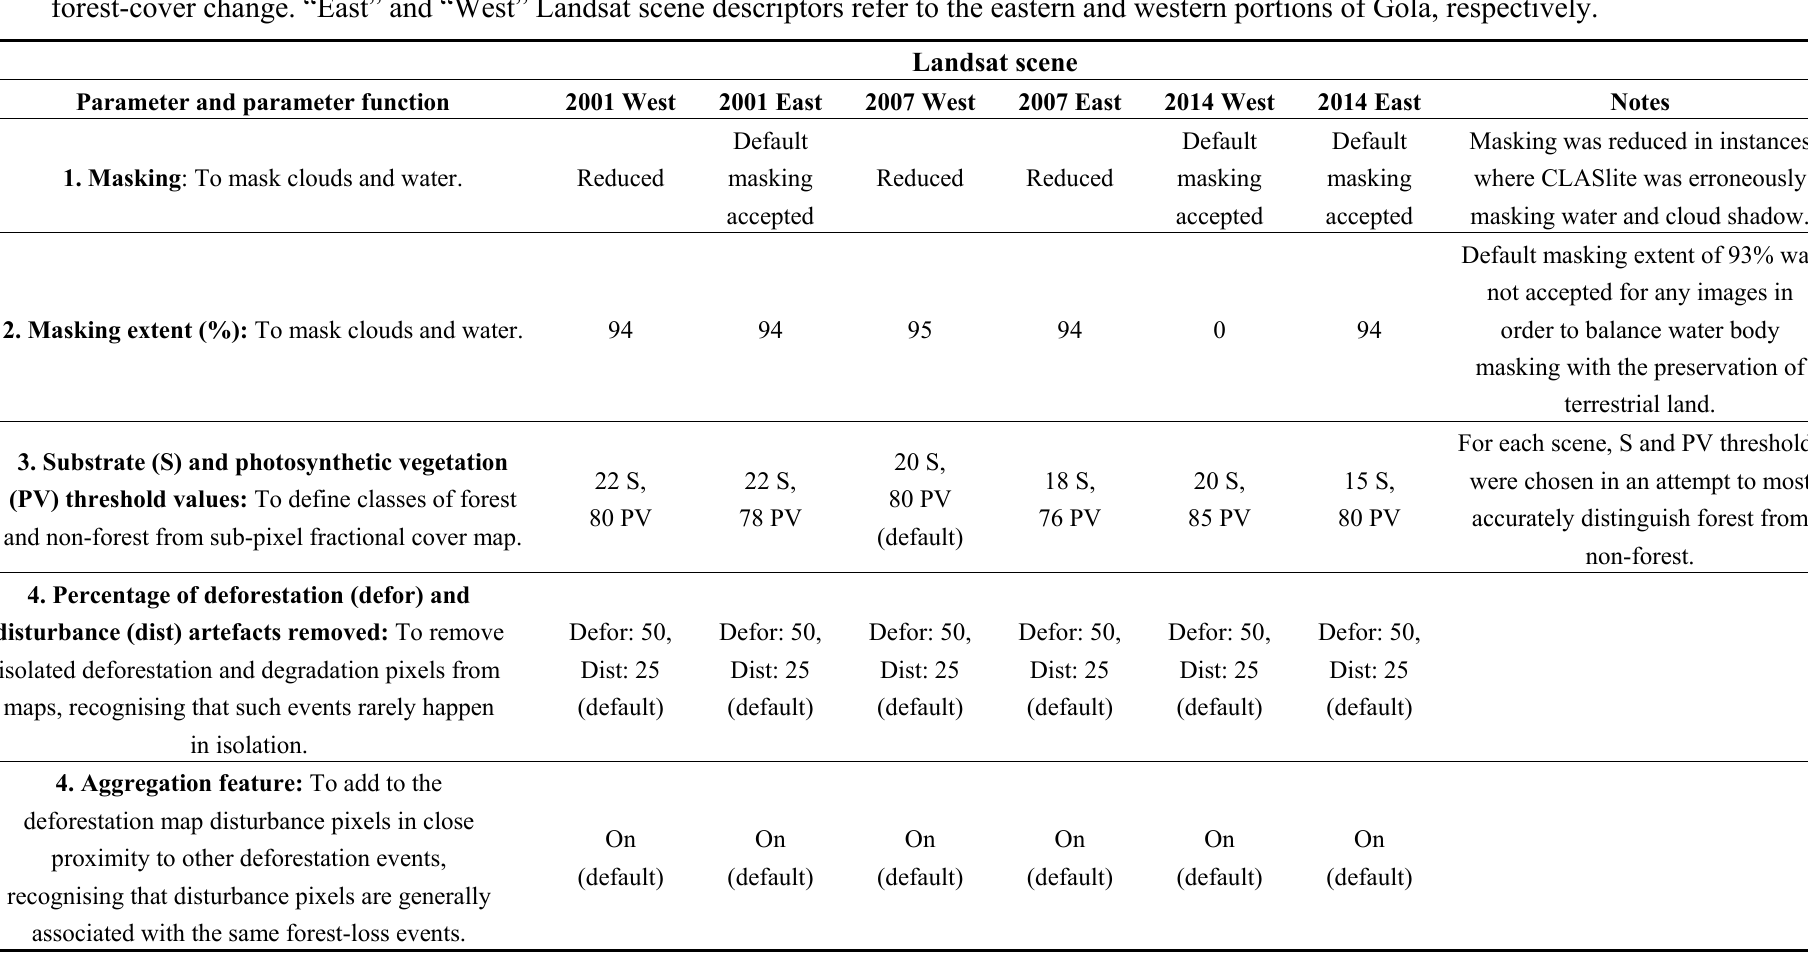
Table A2. Summary of parameter change decisions while classifying each of the six Landsat images over Gola in the Carnegie Landsat Analysis System lite (CLASlite) version 3.1. Numbers before each parameter refer to the CLASlite step during which the option to alter the parameter was offered: 1 = raw image to reflectance, 2 = reflectance to fractional cover, 3 = fractional cover to forest cover, and 4 = forest cover to forest-cover change. “East” and “West” Landsat scene descriptors refer to the eastern and western portions of Gola,